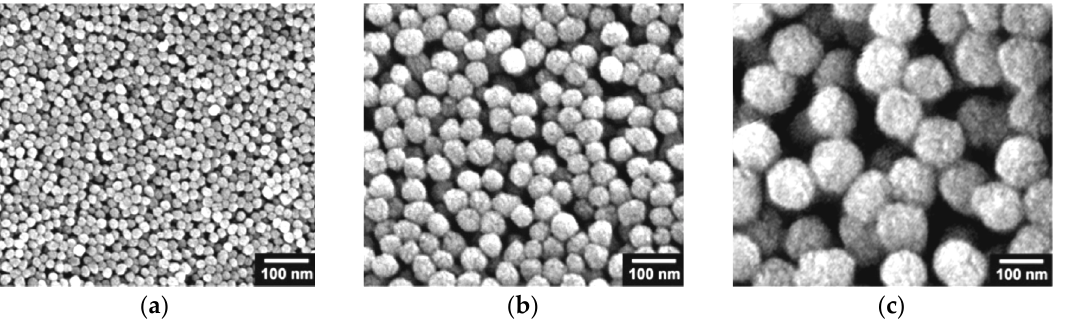
Figure 8. SEM images of PPy nanoparticles with diameter of ( a ) 20 nm; ( b ) 60 nm; and ( c ) 100 nm. Reprinted with permission from [58]. Copyright (2017) American Chemical Society.